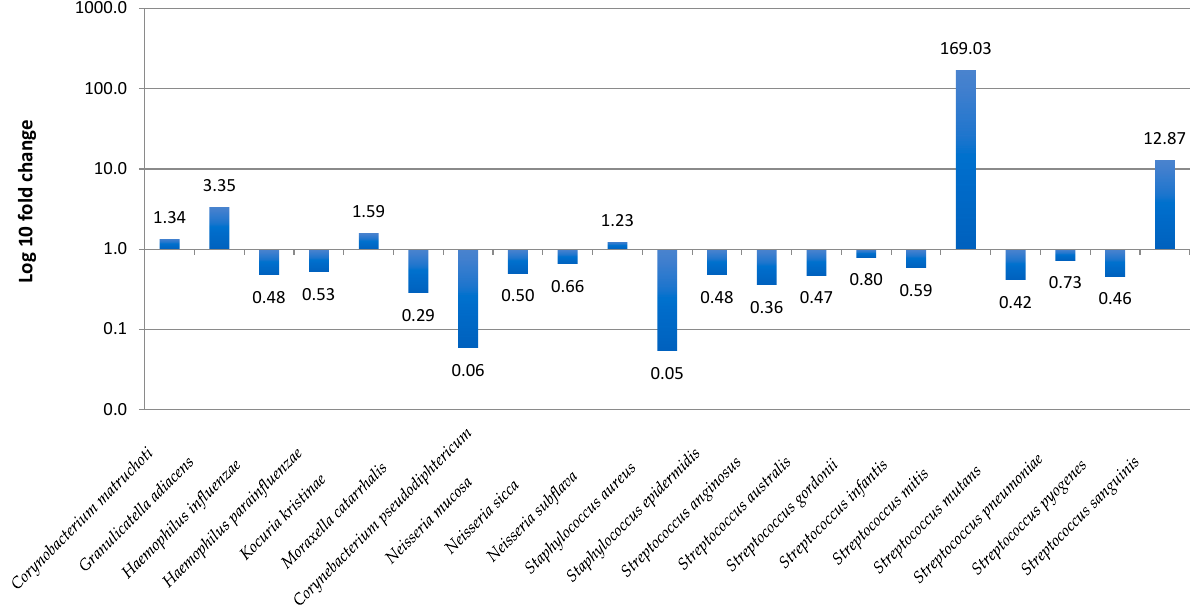
Figure 4. Accurate profiling of pathogenic and commensal microbes in vaccinated and unvaccinated children. Foldchange in microbial species abundance (vaccinated/unvaccinated groups) was calculated by the ∆∆ CT method using the Pan Bacteria 1 genomic DNA to normalize. At least a 5- to 10-fold increase or decrease in relative abundance may be considered significant.